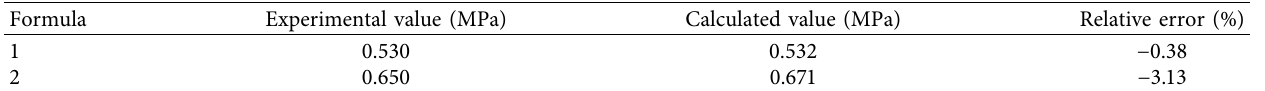
Table 4: Comparison of experimental and calculated values of quasistatic peak pressure.